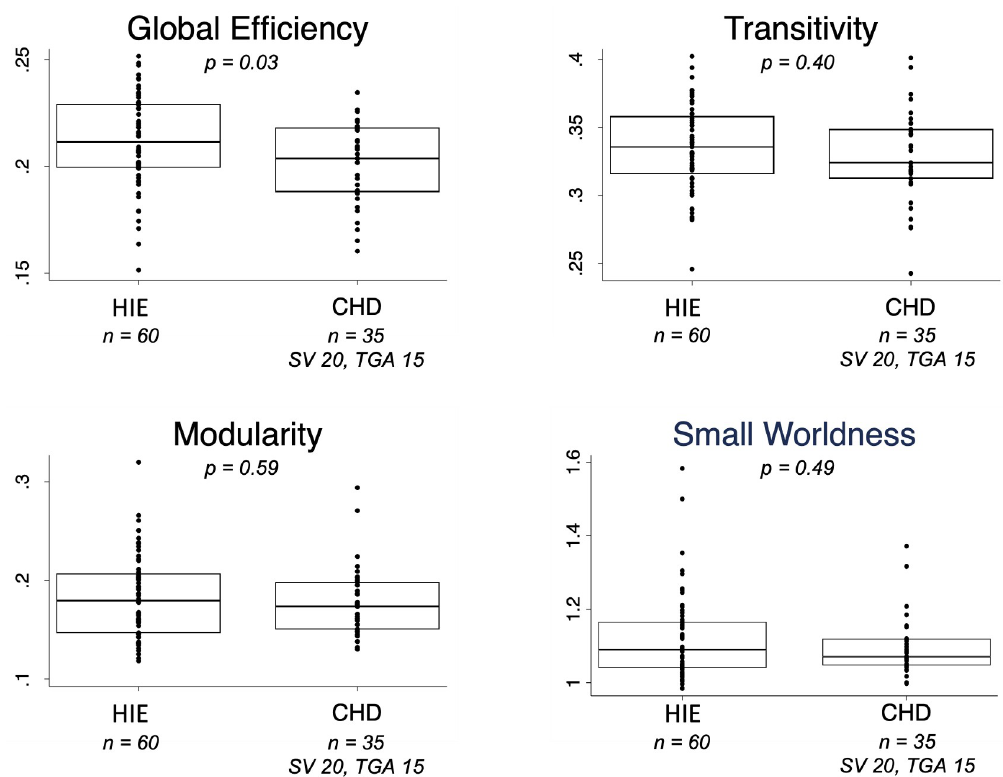
Fig 4. Global graph metrics in hypoxic-ischemic encephalopathy and congenital heart disease. Boxplots and overlying scatter plots depict the medians, interquartile ranges, and individual data points for the following graph metrics: global efficiency, transitivity, modularity, and